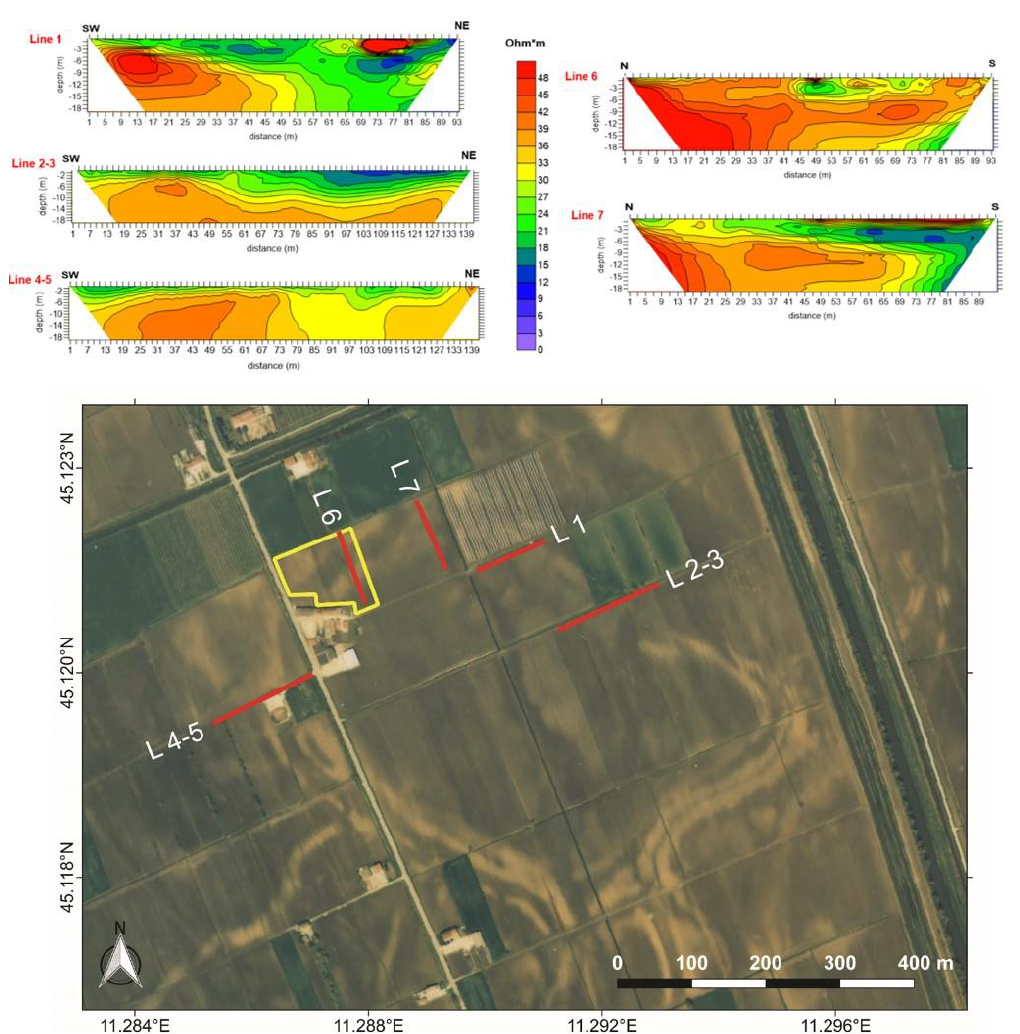
Figure 7. ERT lines results normalized in the range 0–50 Ohm*m with their field localization.